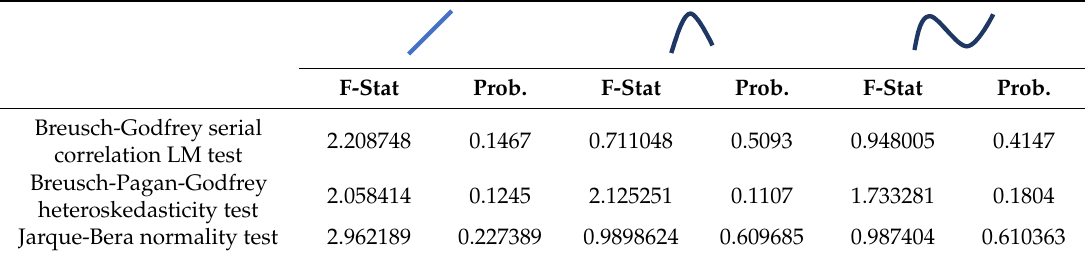
Table 9. Residual diagnostic tests. Table 6. Bounds test and short ‐ run relationship. Table 7. Error correction model and long ‐ run relationship.